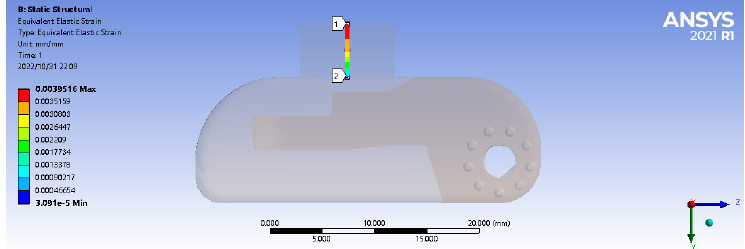
Figure 7. Simulation model of robot finger and elastomer.